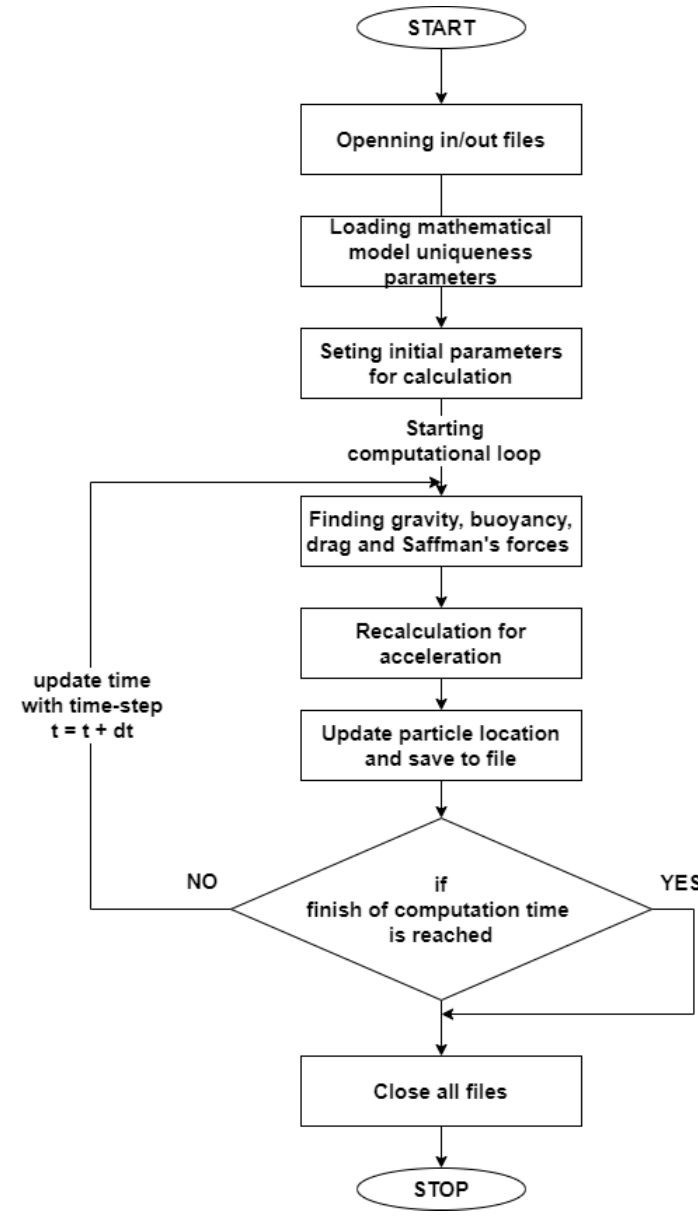
Figure 1. Block diagram of the computer program.